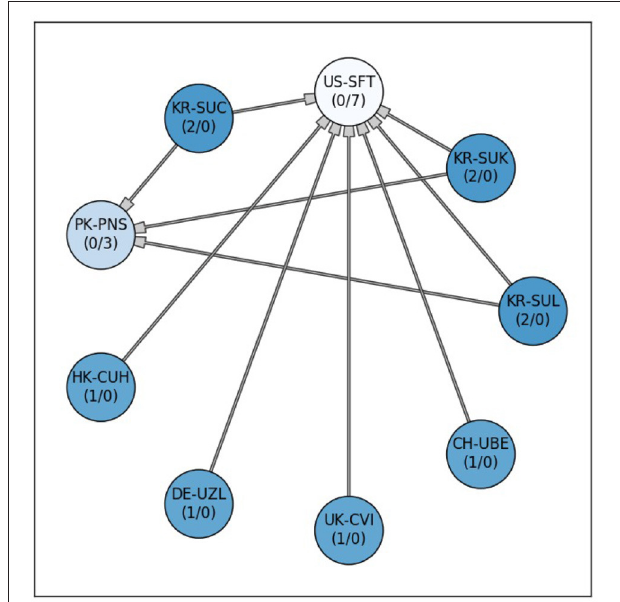
FIGURE 2 | Significant differences between the 9 submitted methods for ISLES 2016. Each node stands for one participating team. A connection between the nodes represents a significant difference between both lesion prediction models. Methods at the tail side of the arrow indicate superiority to the corresponding connected one. The stronger or weaker a model is the more outgoing or incoming connections (#outgoing/#incoming, respectively), are associated with a team’s node. Additionally, the node’s color saturation indicates the strength of a method (differences in Friedman test rank sum), with better methods appearing more saturated (i.e., darker blue). All methods, except for PK-PNS, are significantly better than US-SFT ( post-hoc Dunn test p <